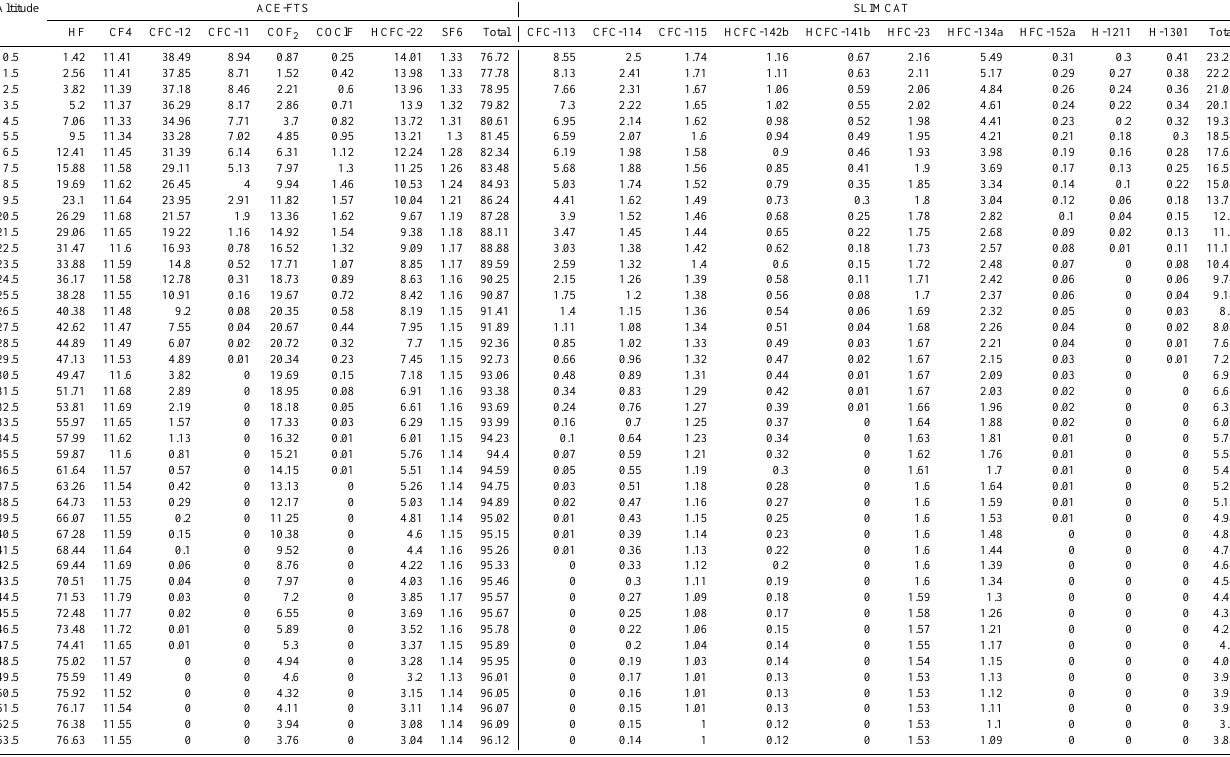
Table A4. The percentage contribution of each species to the total fluorine budget in the latitude bands between 30 ◦ S and 70 ◦ S. Altitude